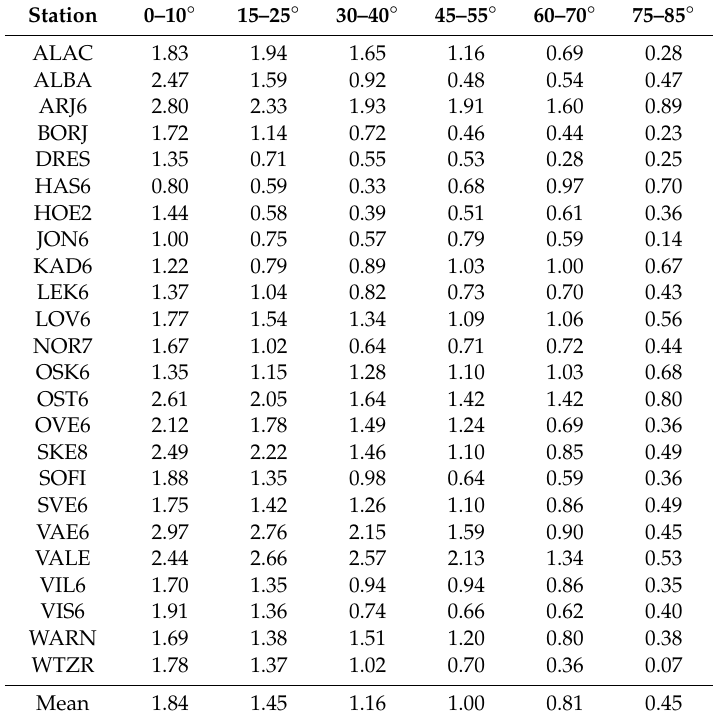
Table A2. RMSs of the phase center correction di ff erences for “ionosphere-free” linear combination depending on the elevation angle. Values are in millimeters.